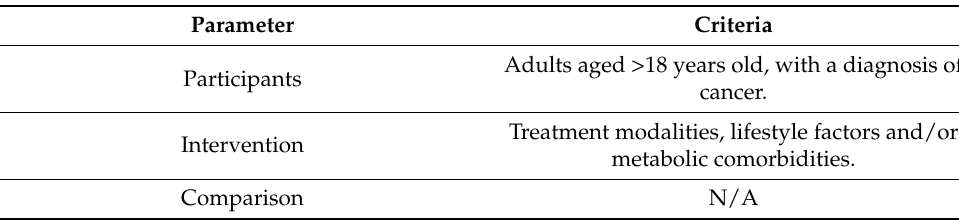
Table 1. PICOS criteria for included